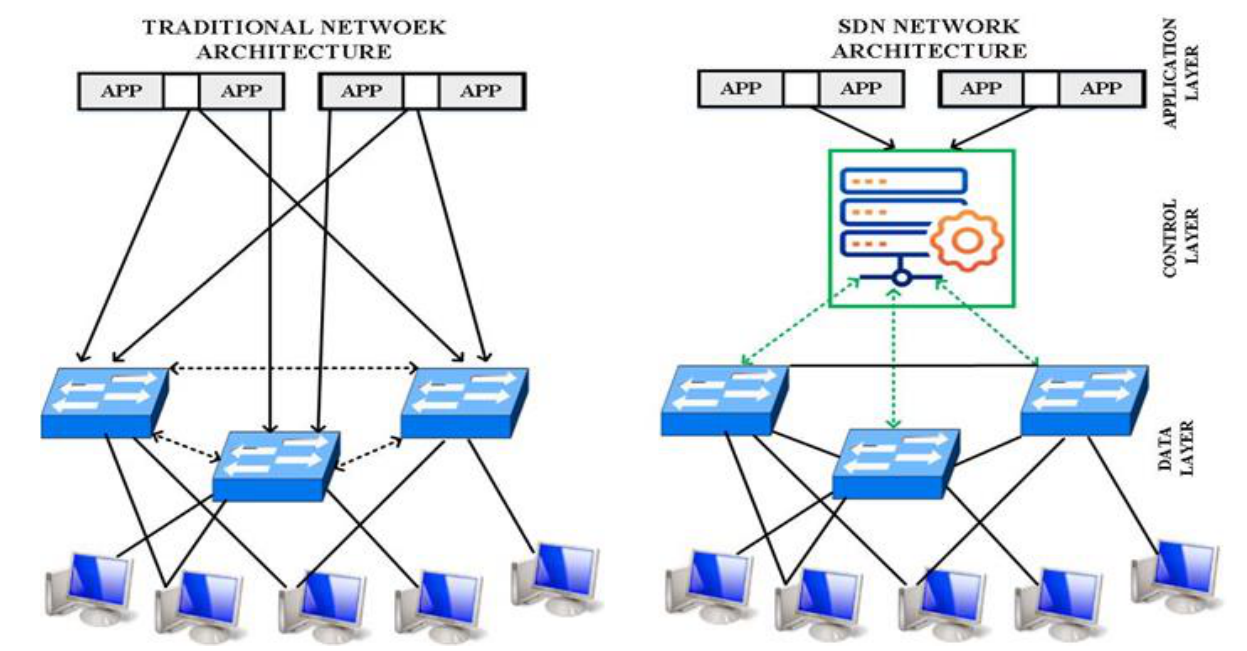
Figure 1. SDN vs. traditional network architecture.